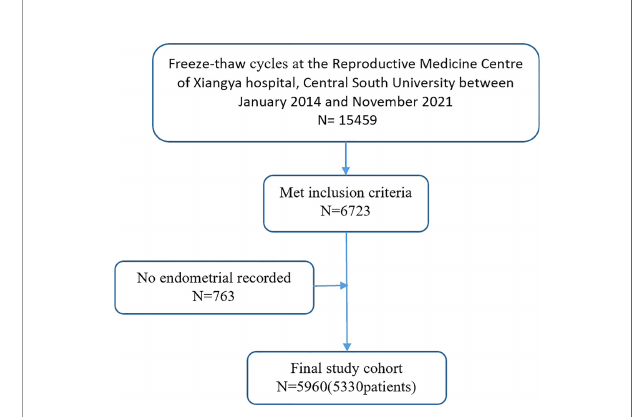
FIGURE 1 | Flowchart of